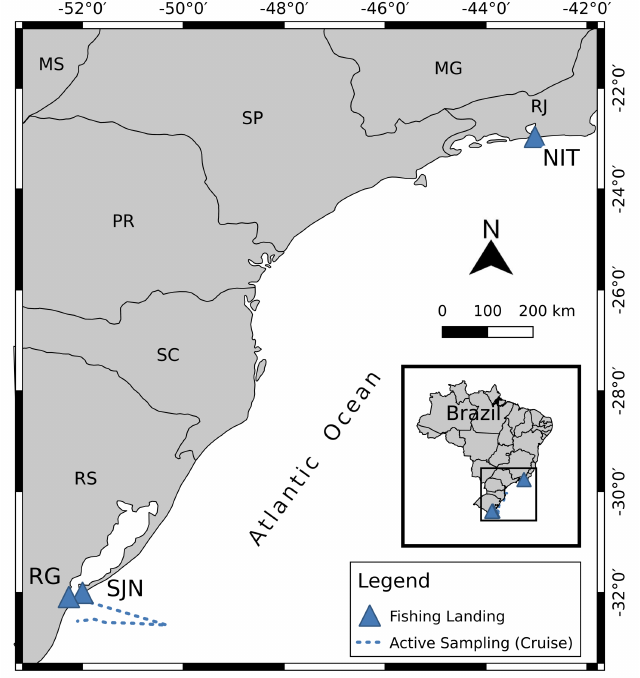
Figure 1. Sampling map of the research cruise carried out under the Multisar project and the continental ports where passive sampling was performed to obtain Sardinella braisliensis specimens for this